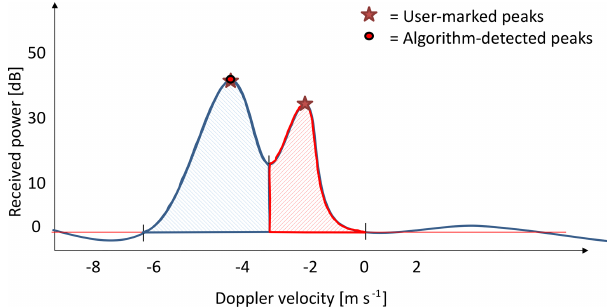
Figure 3. Schematic to visualize how the similarity measure to compare user-marked and algorithm-found peaks in Doppler spec- tra: areas of matching peaks are summed up (blue hatched area), and the areas of mismatched peaks (red hatched) are